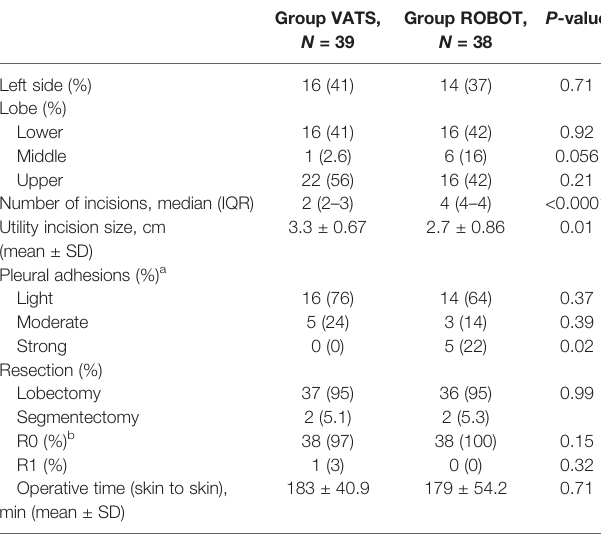
TABLE 3 | Postoperative outcomes and pathological results in the VATS and ROBOT groups of patients.